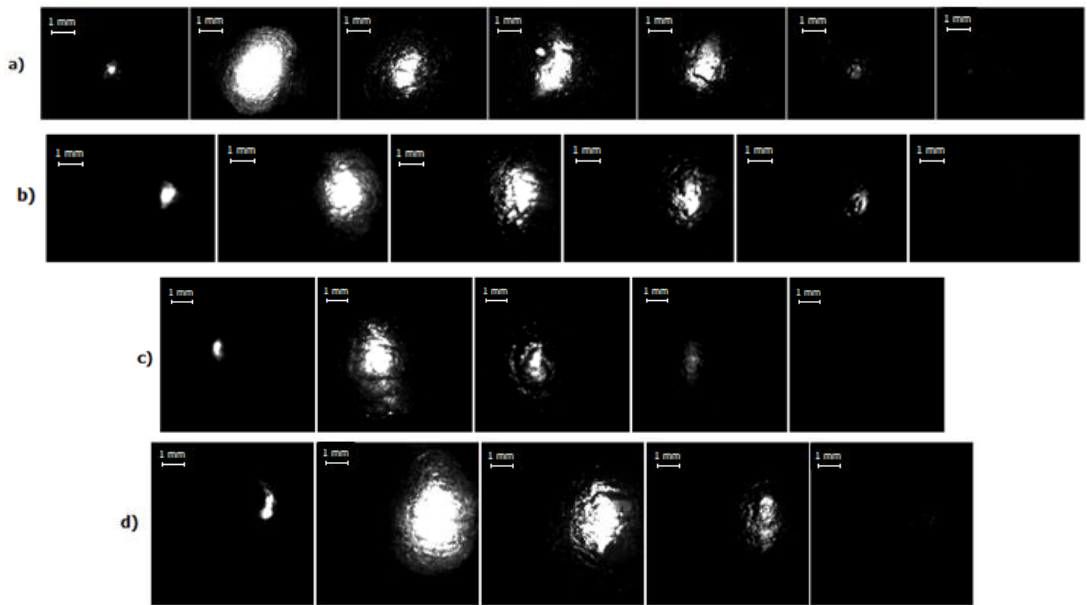
Figure 6. High-speed image recording of the discharge for different current regimes: ( a ) I = 450 A, time interval between presented frames–60 μs, image resolution–128 × 96 px, frame rate–100,000 fps; ( b ) I = 660 A, time interval between presented frames–60 μs; image resolution–128 × 96 px, frame rate– 100,000 fps; ( c ) I = 800 A, time interval between presented frames–65 μs; image resolution–128 × 128 px, frame rate–75,000 fps; ( d ) I = 1000 A, time interval between presented frames–65 μs; image resolution–128 × 128 px, frame rate–75,000 fps.